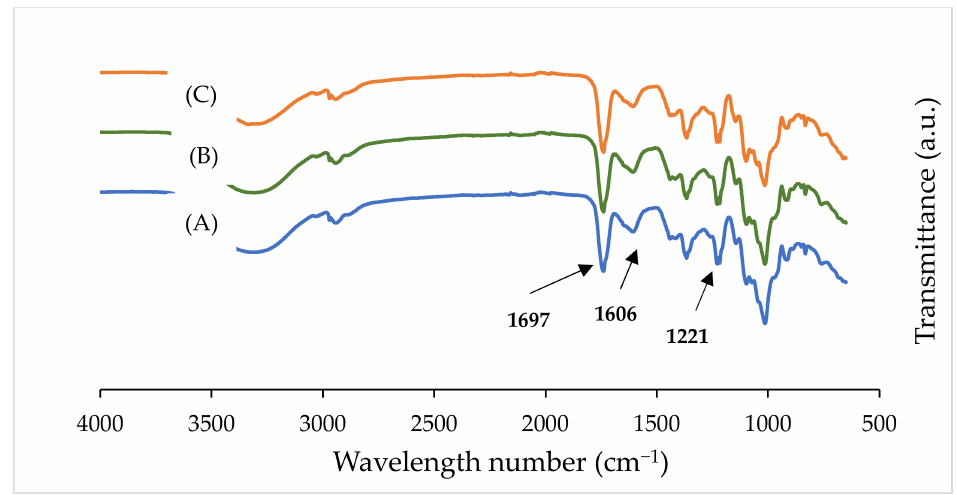
Figure 5. FTIR spectra of pectin films ( A ) incorporated with: ( B ) MMT and ( C )